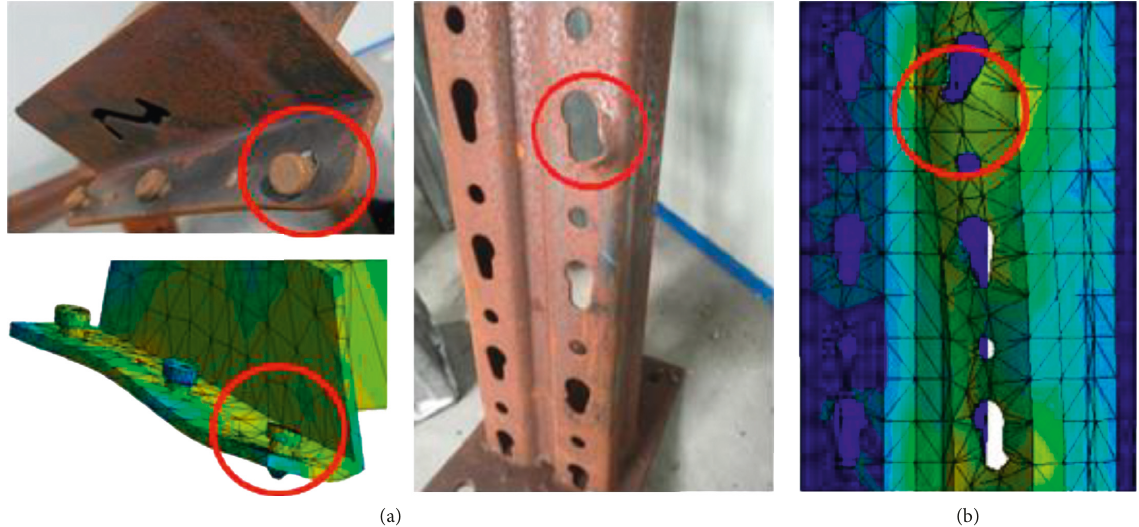
Figure 6: Comparison of simulation and experimental deformation. (a) Deformation of rivets and beam-end connector and (b) gap of holes.